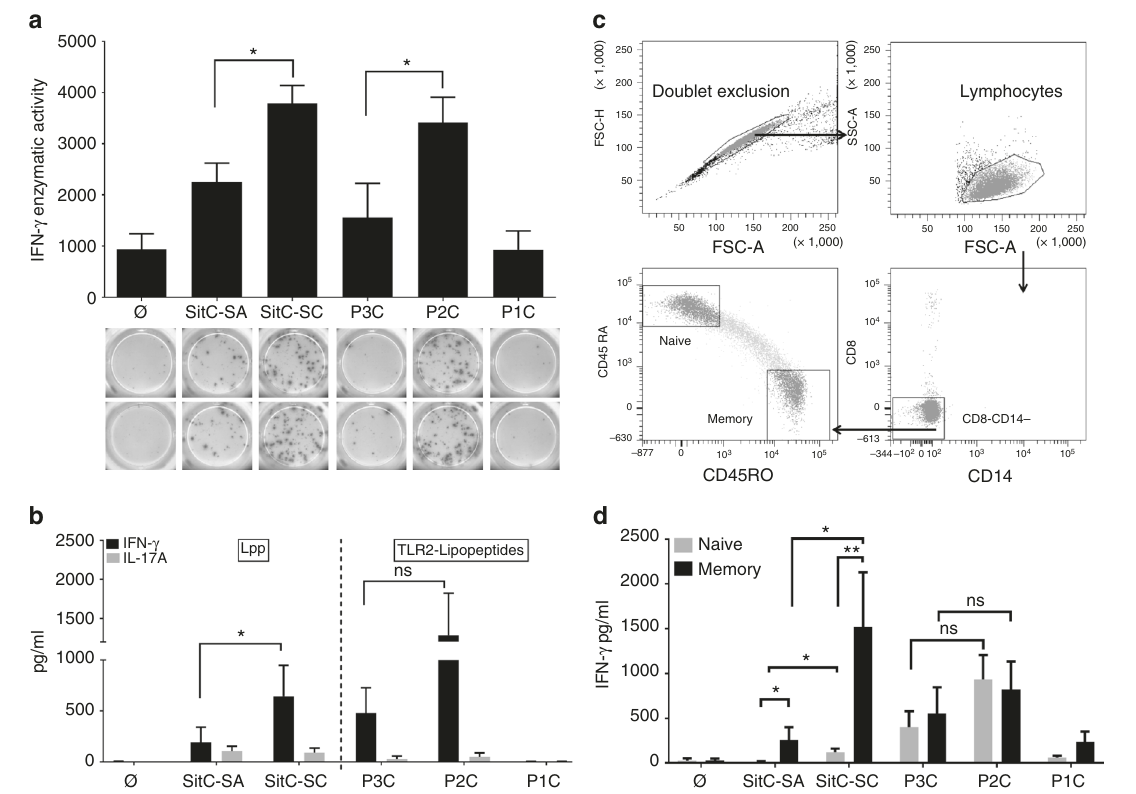
Fig. 6 Puri fi ed SitC-SC induced a stronger Th1 cytokine response from MoDC/T cocultures than SitC-SA. ( a ) Activation of IFN γ -secreting T cells was measured in PBMC spiked with MoDC prestimulated with TLR2 ligands (0.1 μ g/ml), i.e., SitC-SC, SitC-SA, P2C, P3C, or left unstimulated (Ø) or treated with P1C as controls. After 2.5-h stimulation, MoDC were added to freshly thawed autologous PBMC. IFN γ -secreting cells were quanti fi ed by ELISPOT